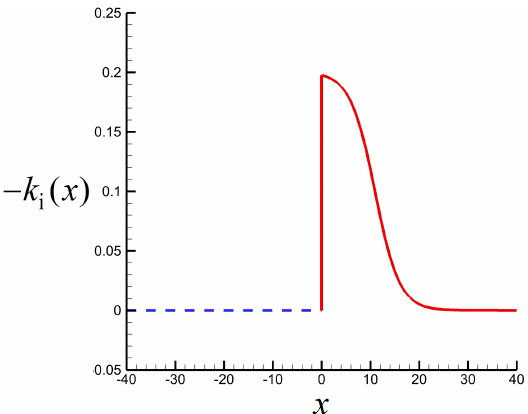
− ) versus non-dimensional distance